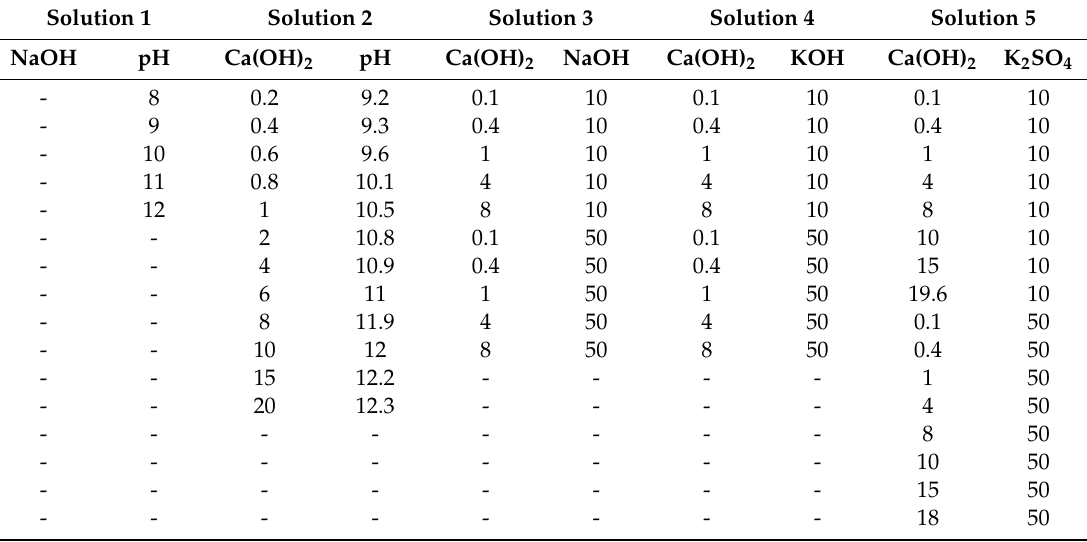
Table 2. Preparation of the model solutions (concentrations are shown in mmol / L